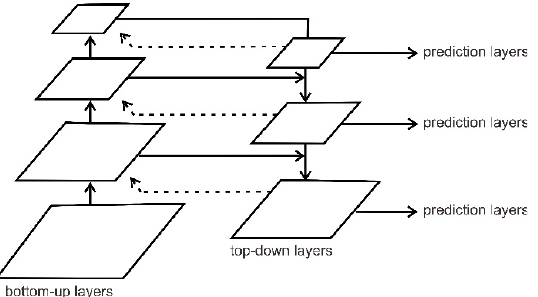
Figure 5. Visualization of recursive feature pyramid networks (RFP). The feedback connections are used to learn more deeply about the features’ information.